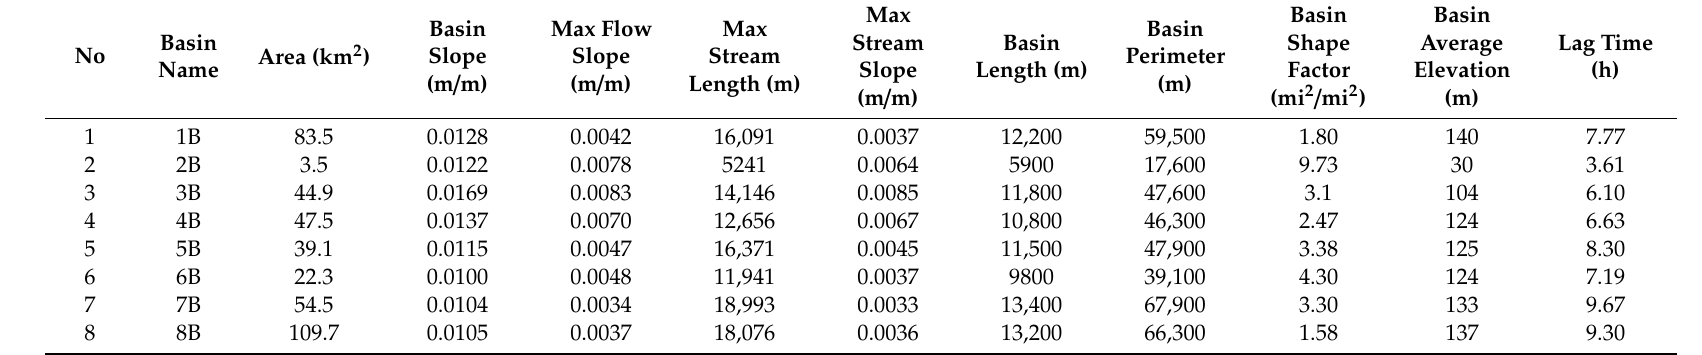
Table 2. The morphology characteristics of the basins in the study